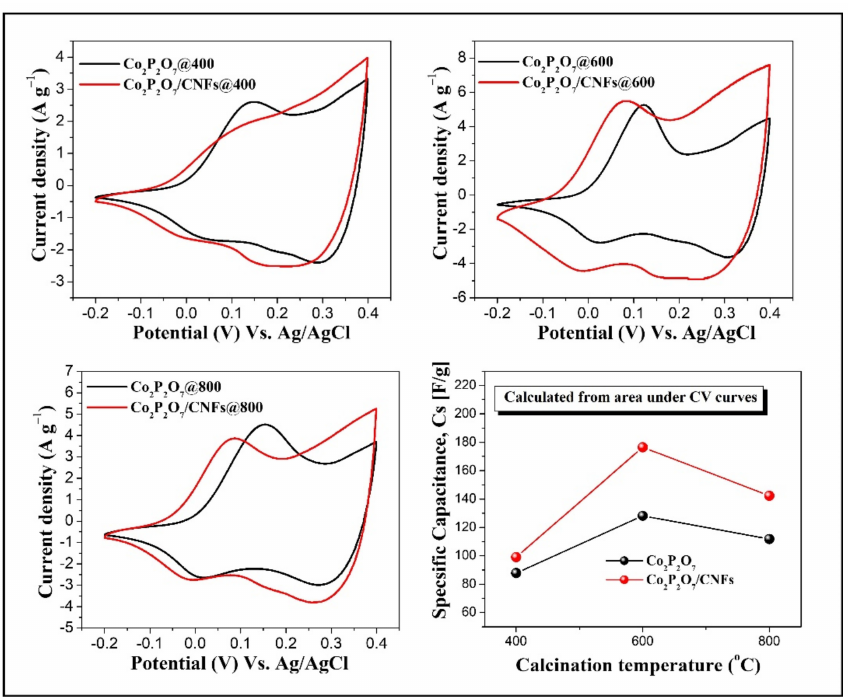
Figure 9. Comparative CV curves at a scan rate of 20 mV s − 1 with calculated specific capacitance of pure Co 2 P 2 O 7 versus Co 2 P 2 O 7 /CNFs calcined at 400 ◦ C, 600 ◦ C and 800 ◦ C under an argon